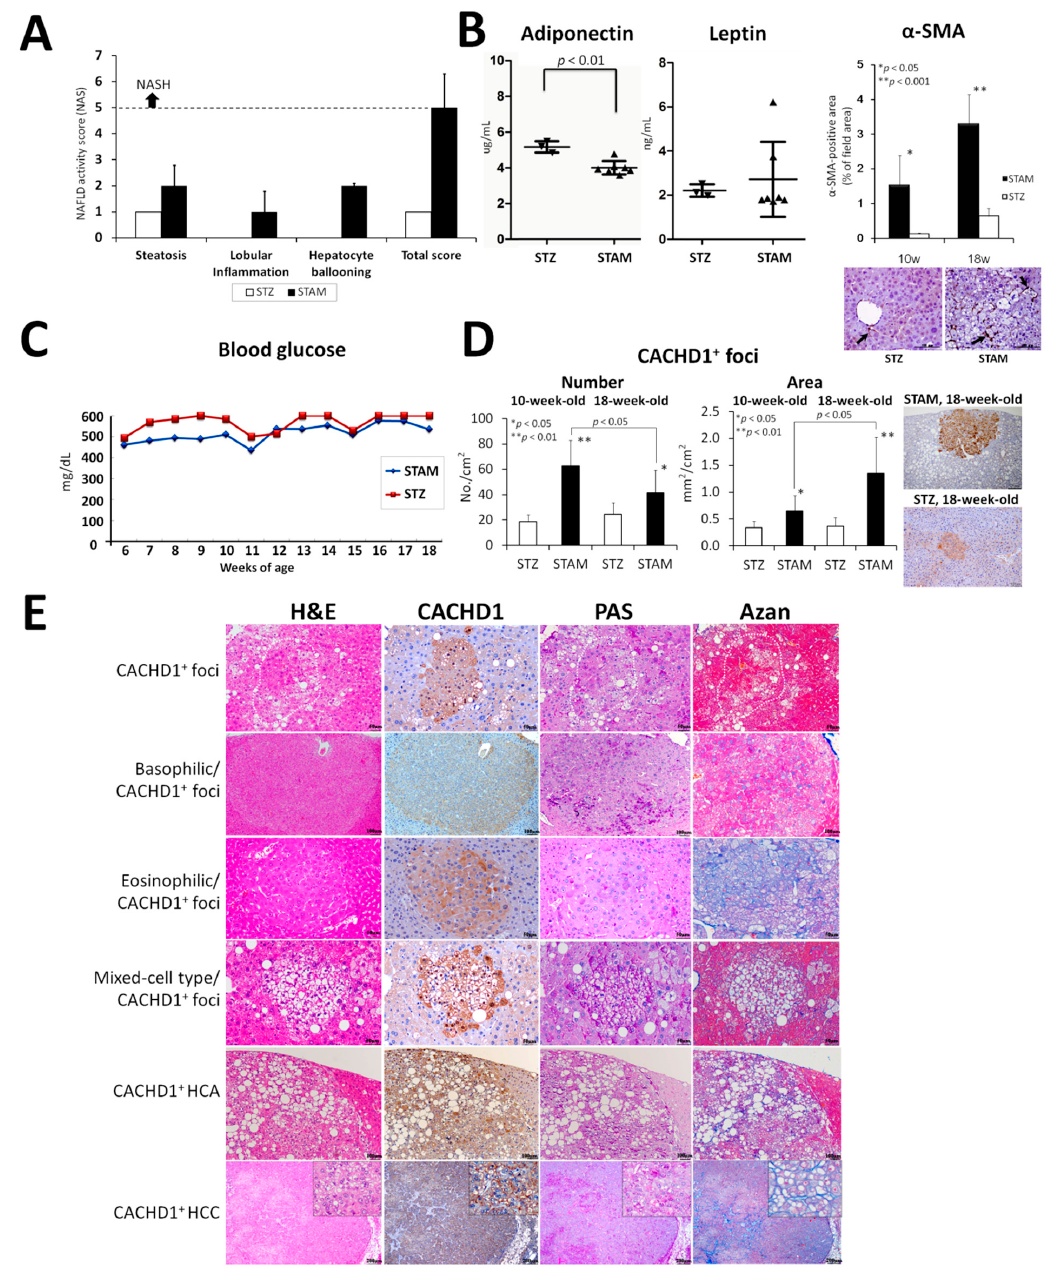
Figure 1. ( A ) Steatosis, lobular inflammation, hepatocyte ballooning and total non-alcoholic fatty liver disease (NAFLD) activity scores in 18-week-old Stellic Animal Model (STAM) and streptozotocin (STZ) control mice. ( B ) Serum blood adiponectin, leptin and α -SMA levels in 18-week-old mice, ( C ) Blood glucose levels, ( D ) Numbers and areas of CACHD1 + foci developed in 10 and 18-weeks old mice. ( E ) Representative pictures of H&E, PAS, AZAN staining, and CACHD1 immunohistochemistry in the livers of STAM mice. CACHD1 + preneoplastic lesions included basophilic, eosinophilic, mixed-cell type, and those which were undetectable histopathologically. Note the elevation of PAS-positive (glycogenation) areas in all lesions, Azan-positive (fibrosis) areas in AF (mainly eosinophilic and mixed-cell type foci) and liver tumors, and strongly positive for CACHD1 nuclei and cytoplasm of the ballooned cells in CACHD1 + alone and mixed-cell type foci. *, p < 0.05, **, p < 0.01. Scale Bar: 100 μ m ( B , D ); 50 μ m, 100 μ m and 200 μ m in foci, HCA and HCC images, respectively, in ( E ).